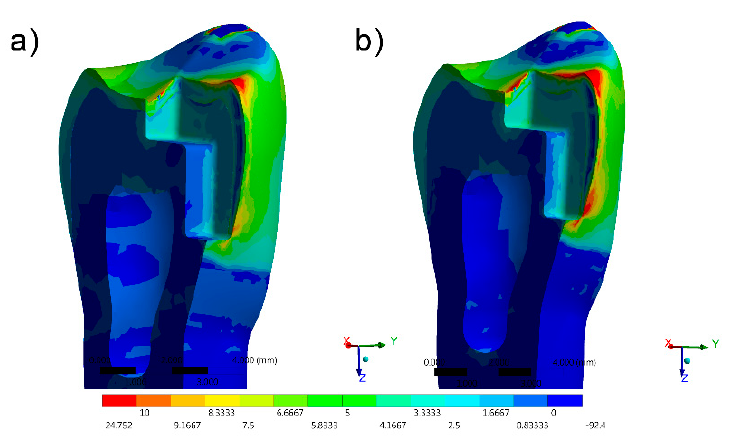
Figure 4. FEA Maximum Principal Stress results in the direct access design. ( a ) Bulk-fill flowable and ( b ) Conventional.Figure 5 FEA Maximum Principal Stress results in the mesio-occlusal design. ( a ) Bulk-fill flowable and ( b ) conventional.